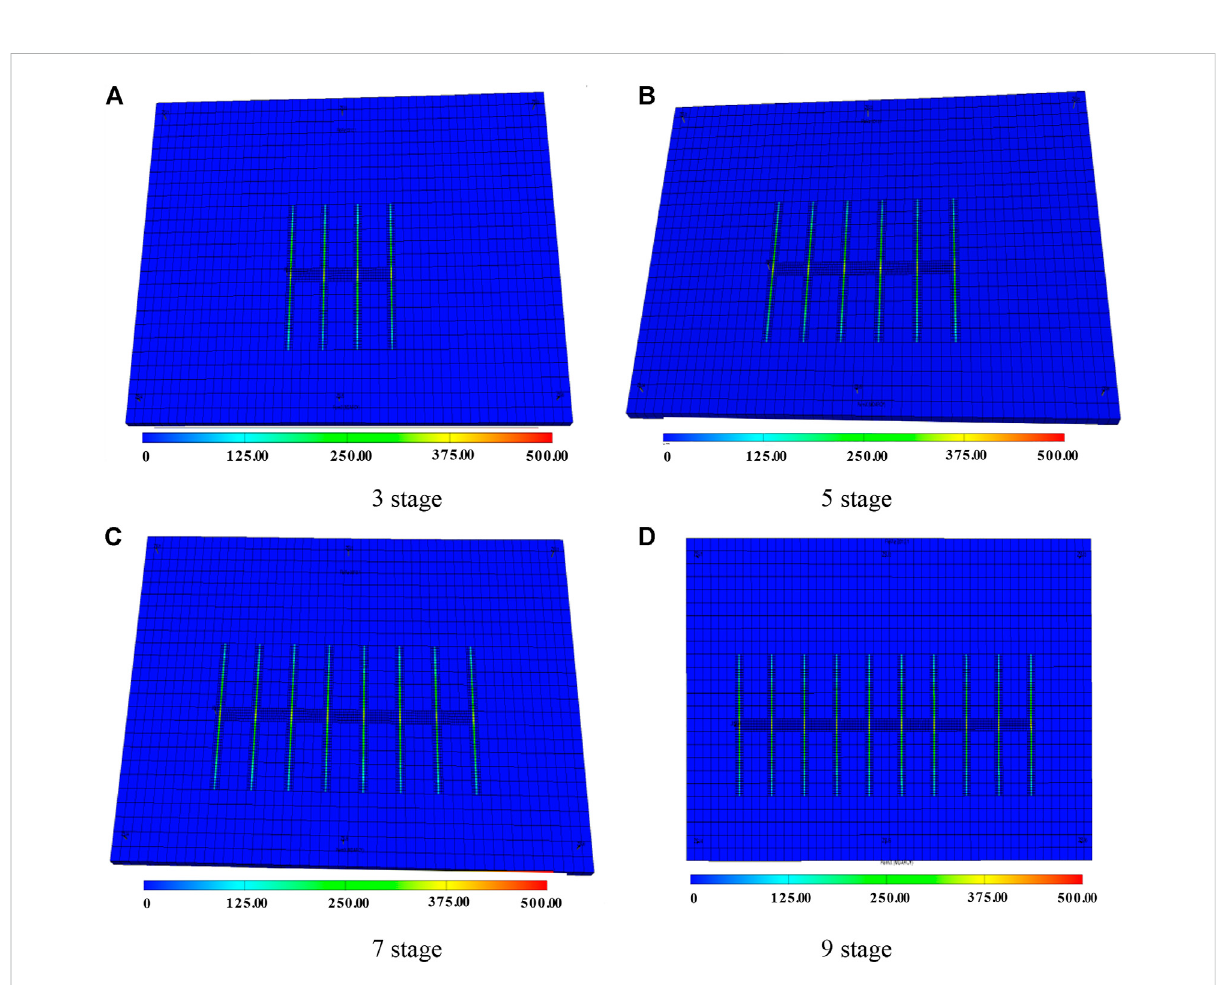
FIGURE 10 In fl uence of different horizontal well length on reservoir seepage fi